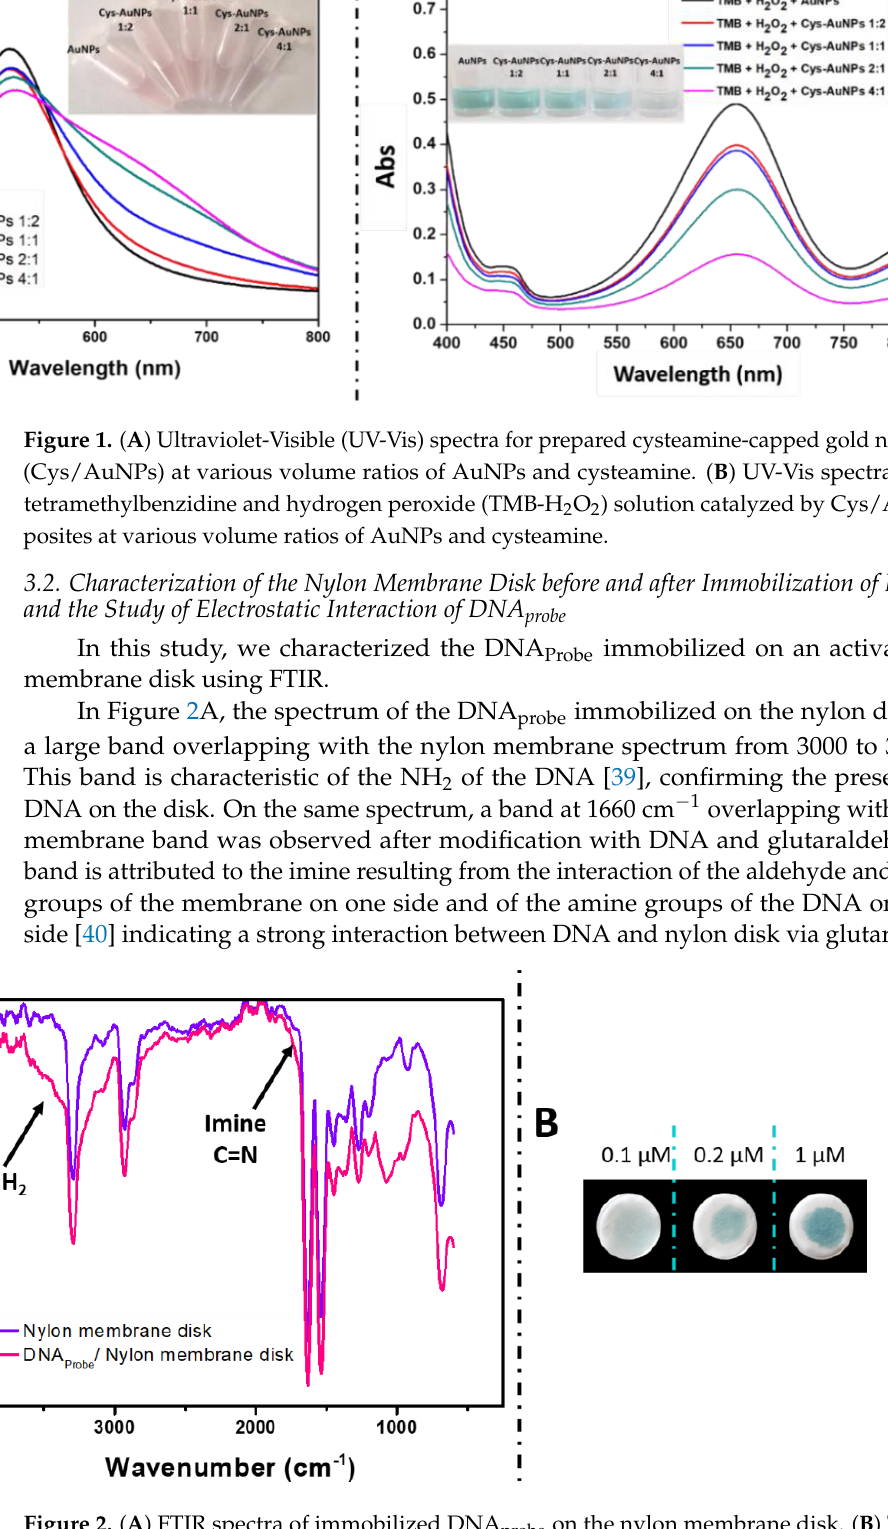
Figure 2. ( A ) FTIR spectra of immobilized DNA probe on the nylon membrane disk. ( B ) TMB/H 2 O 2 solution catalysis by Cys/AuNPs in the presence of different concentrations of DNA probe immobi- lized on the nylon